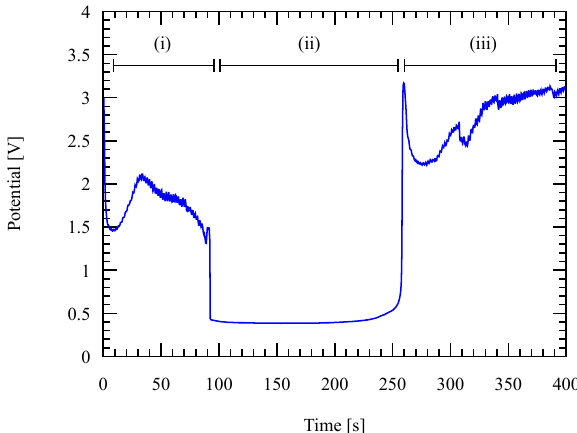
Figure 14. Reverse deposition potential as a function of time during the reverse current treatment to remove the native oxide layer on Al seed layer with a fixed current density of 10 mA/cm 2 .